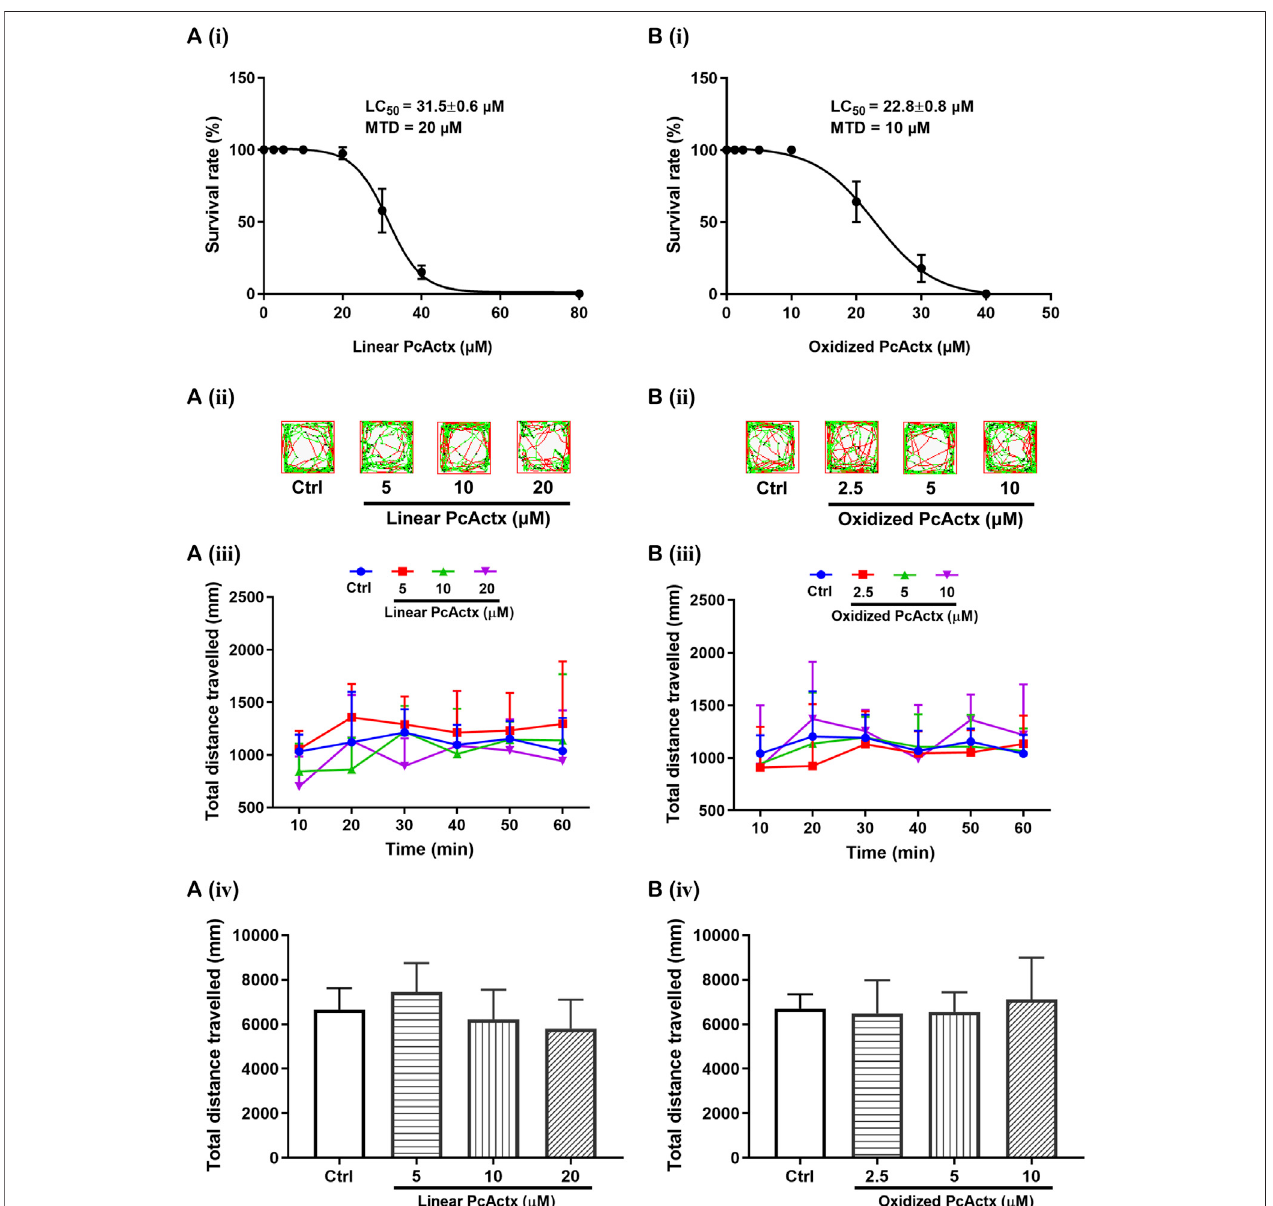
FIGURE 5 | Survival and behavioral toxicity of zebra fi sh larvae after 24 h exposure to PcActx peptides. (A) Linear PcActx peptide. (B) . Oxidized PcActx peptide. ( ⅰ ) Survival rates of zebra fi sh larvae. Data were expressed as means ± SD (n (cid:2) 3). ( ⅱ ). Representative patterns of locomotion behavior of zebra fi sh larvae. The swimming trajectory was recorded every 10 min and is represented by curves. The instantaneous velocity was detected and displayed in different colors (black, < 2 mm/s; green, 2 – 8 mm/s;red, > 8 mm/s).( ⅲ ).Changesintotaldistancetravelledbyperiod.( ⅳ ).Statisticalanalysisoftotaldistancetravelled.Dataareexpressedasmeans ± SD(n (cid:2) 10 –